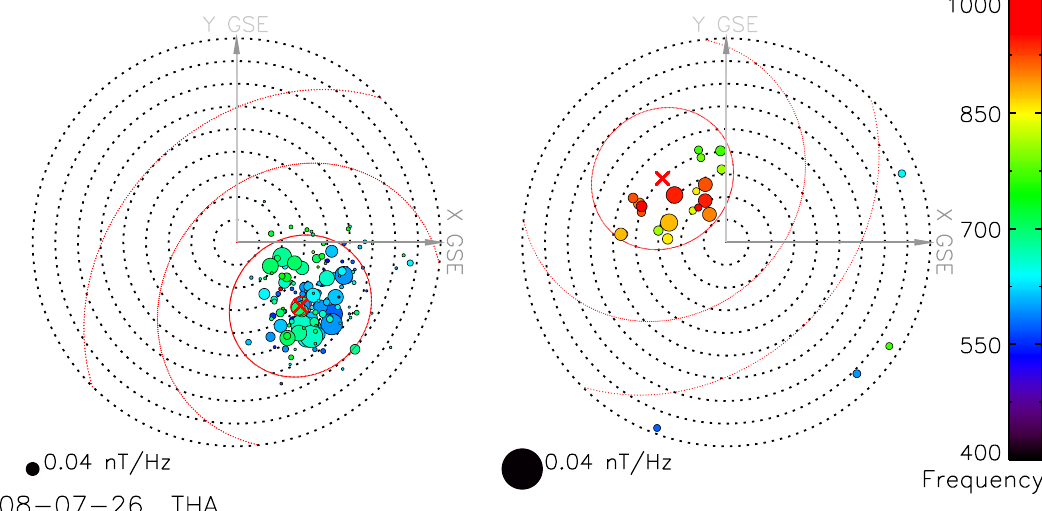
Fig. 3. The k -vector directions of the wave packets. The Sun is to the right, and the polar axis is along Z GSM . The background magnetic field direction is indicated by the red cross in the circle. The opposite direction is indicated by the red cross (left). The colors of the circles show the wave frequency according to color bar; the radius of the circles is proportional to the wave magnetic field amplitude shown by black circle.